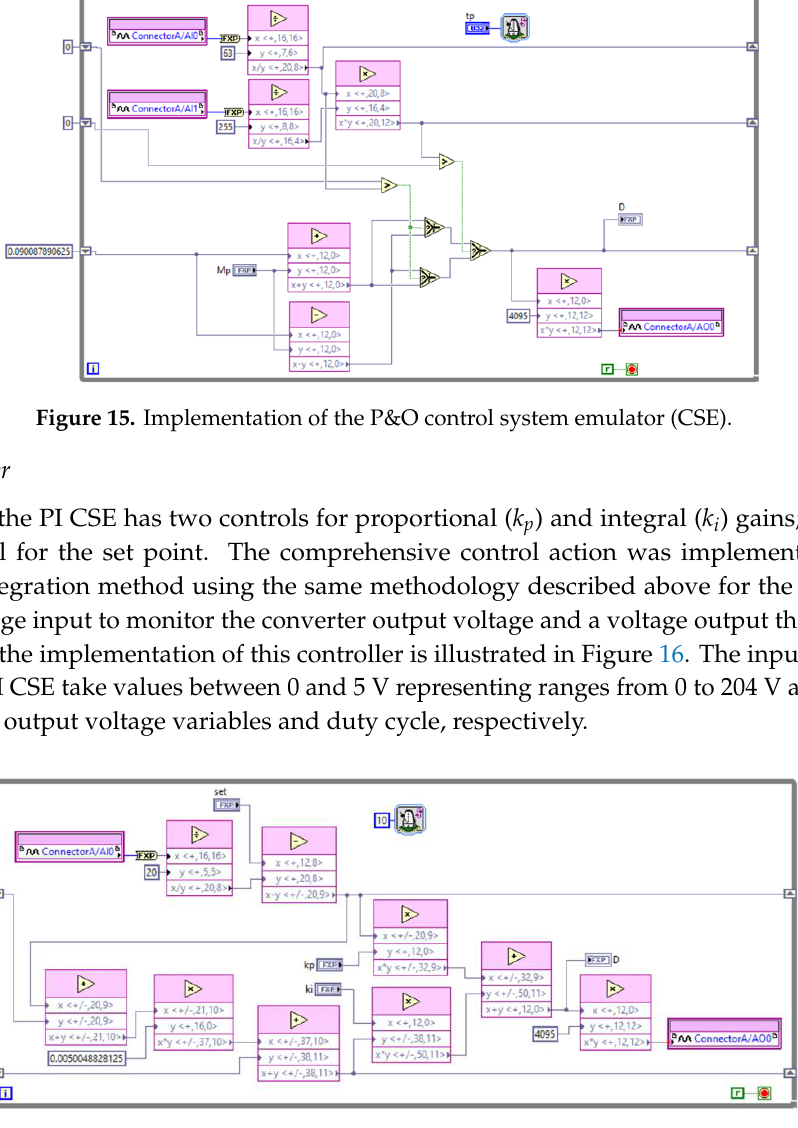
Figure 16. PI CSE implementation.